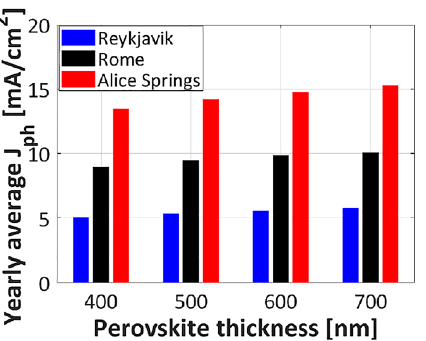
Figure9: Yearlyaveragephotocurrentdensityofbi-facial2Ttandem with c-Si bottom cell passivated with poly-SiO x : comparison be- tween different perovskite absorber thicknesses and different lo- cations. Albedo value considered here is 0.44.